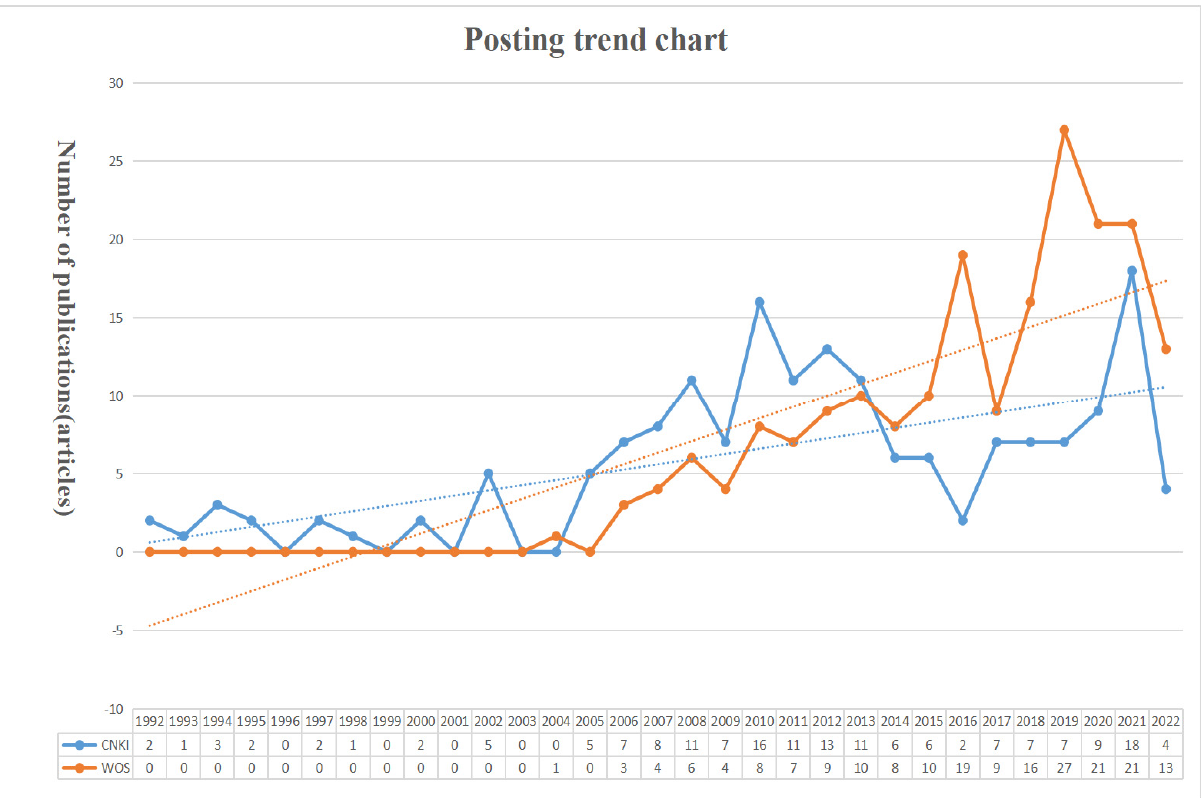
Figure 1. Publication trends.